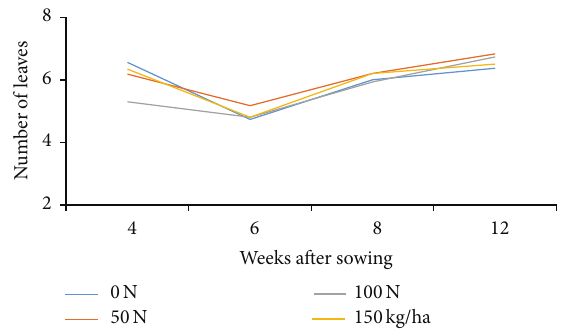
Figure 7: Number of leaves’ response to different nitrogen rates throughout the period of the